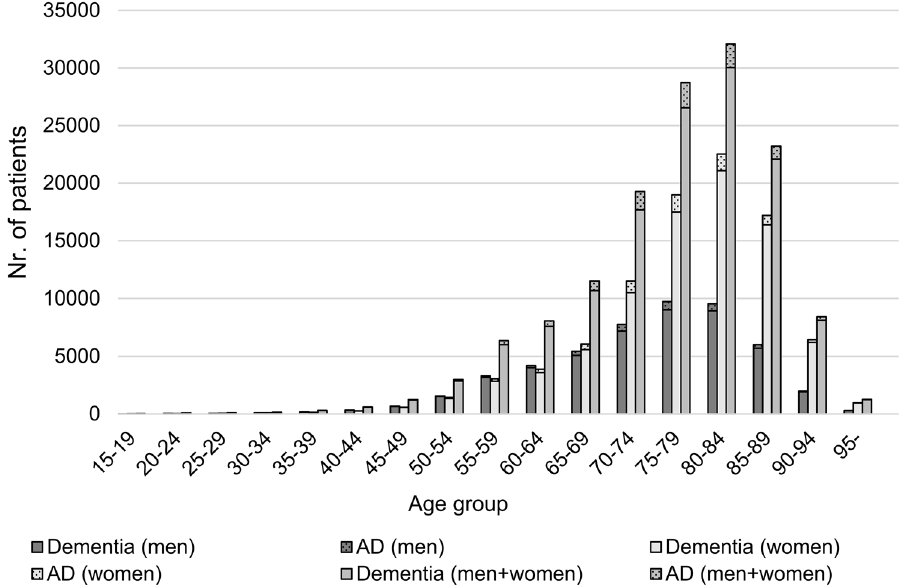
Figure 3. Cases of dementias and AD between 2011 and 2016 by age groups. The bars indicate the total dementia, of which AD is highlighted with